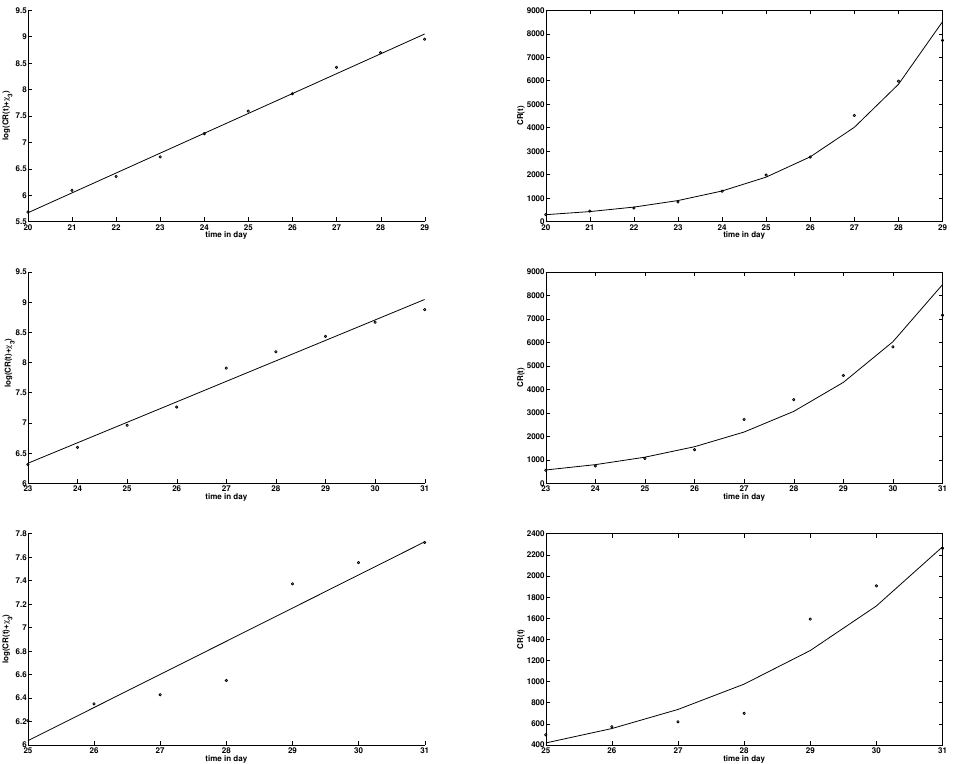
Figure 2. In the left side figures, the dots correspond to t → ln ( CR ( t ) + χ 3 ) , and in the right side figures, the dots correspond to t → CR ( t ) , where CR ( t ) is taken from the cumulated confirmed